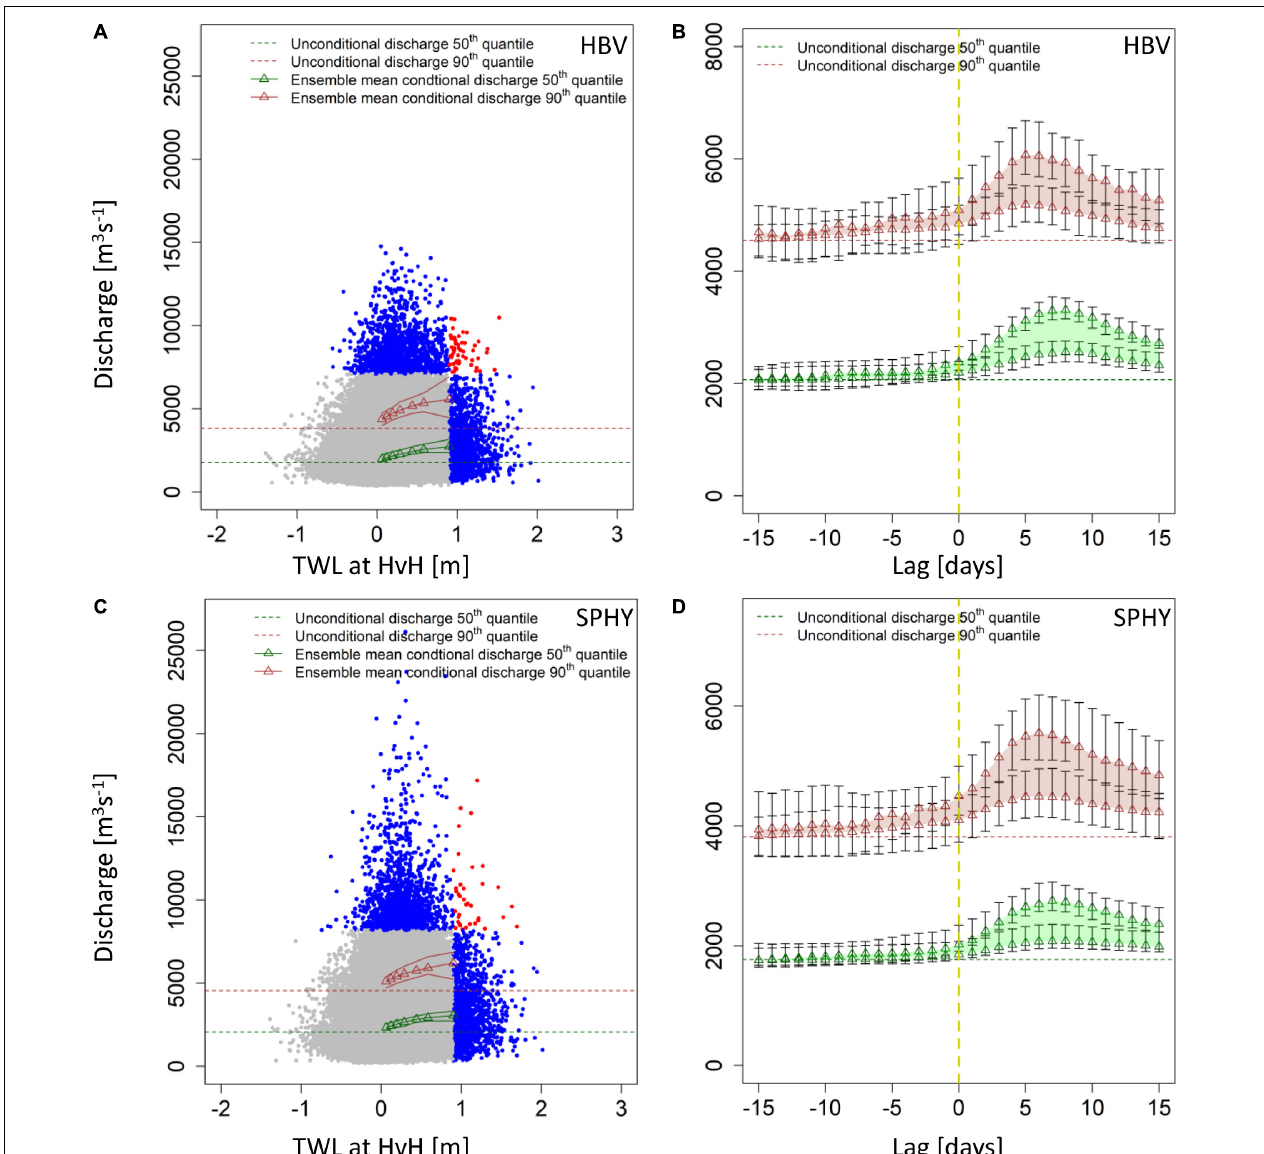
FIGURE 8 | Scatter plot of coastal water levels and discharge for a lag of 3 days (A) HBV and (C) SPHY) and 16 ensemble members. Events exceeding the 99 th quantile of either of the variables are marked in blue. Events exceeding the 99 th quantile of both variables are marked in red. The triangles (green/brown) represent the ensemble mean of the conditional discharge (50 th and 90 th ). The green solid lines represent the spread of ensemble i.e., 5 th and 95 th quantiles of the conditional discharge (50 th quantile). Similarly, the brown solid lines represent the 5 th and 95 th quantiles of the conditional discharge (90 th quantile). Conditional discharge plot for 50 th and 95 th quantile of surge [ (B) HBV and (D) SPHY]. The green band, represents the conditional discharge distribution i.e., the discharge distribution between the 50 th and 90 th quantile only for the cases where the total water level is above 50 th quantile. Similarly, the brown band represents the conditional discharge distribution i.e., the discharge distribution between the 50 th and 90 th quantile only for the cases where the total water level is above 90 th quantile. The upper and lower green triangle represent the mean of the 50 th and 90 th quantile of discharge conditioned on 50 th quantile of TWL. Similarly, the upper and lower brown triangle represent the mean of the 50 th and 90 th quantile of discharge conditioned on 90 th quantile of TWL. The vertical yellow dash line indicates the time lag zero. The error bar on triangle represent the confidence interval estimates of the mean (5 th and 95 th quantiles) from 16 ensemble